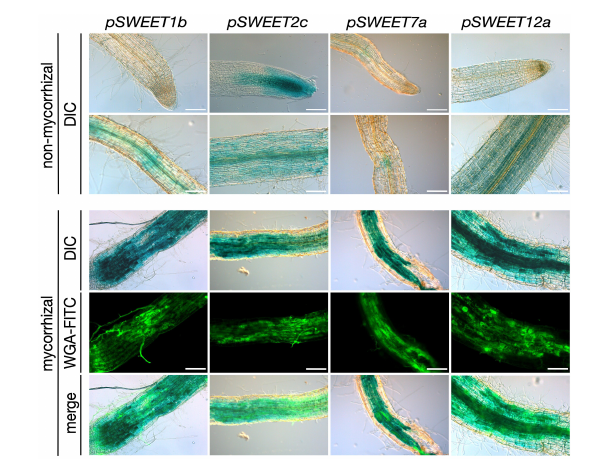
FIGURE 1 | Promoter-reporter assay of S. tuberosum SWEET genes during AM symbiosis. A 2 kb fragment upstream of the ATG of the S. tuberosum SWEET genes 1b , 2c , 7a , or 12a was cloned in front of the GUS ( β -glucuronidase ) reporter gene and transformed in S. tuberosum . Composite plants were inoculated with R. irregularis and harvested 4 wpi (weeks post inoculation). β -Glucuronidase staining was carried out in non-mycorrhizal control roots and mycorrhizal roots. Fungal colonization was visualized by WGA-FITC (wheat germ agglutinin-fluorescein isothiocyanate) counterstaining labeling the fungal cell wall. Scale bars represent 200 µ m. DIC, differential interference contrast; WGA-FITC signal is shown in